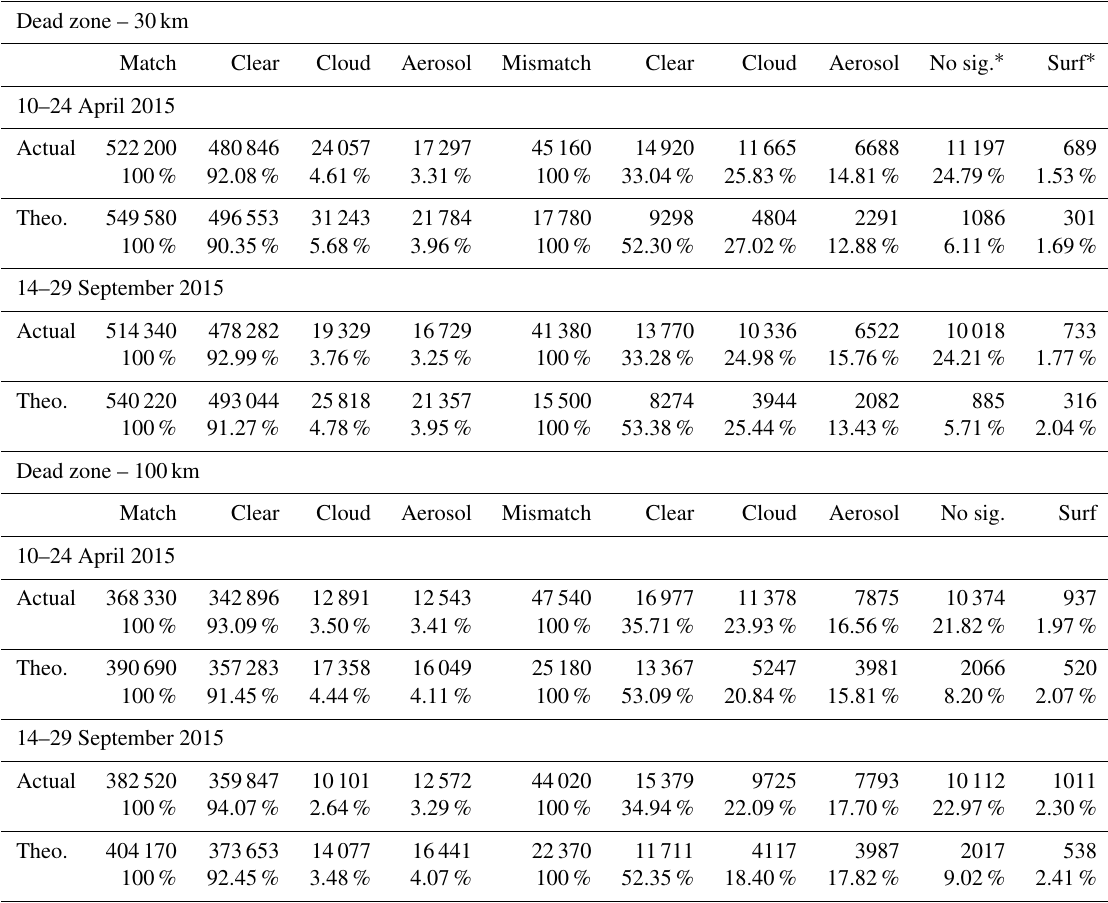
Table 3. Summary of comparison between observed nadir profiles and reconstruct nadir profiles. Dead zone – 30km